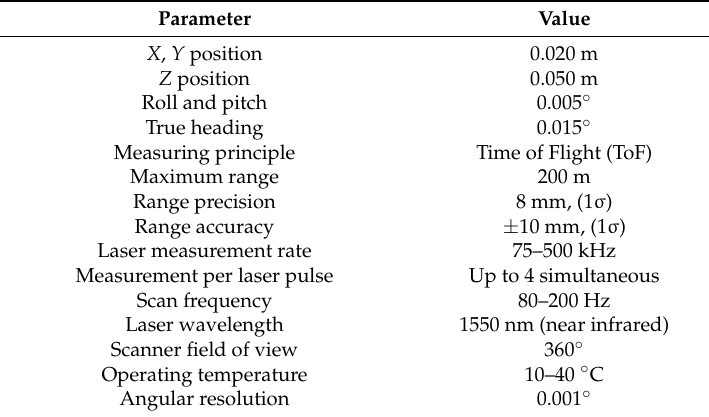
Table 1. Technical specifications of Optech LYNX Mobile Mapper.